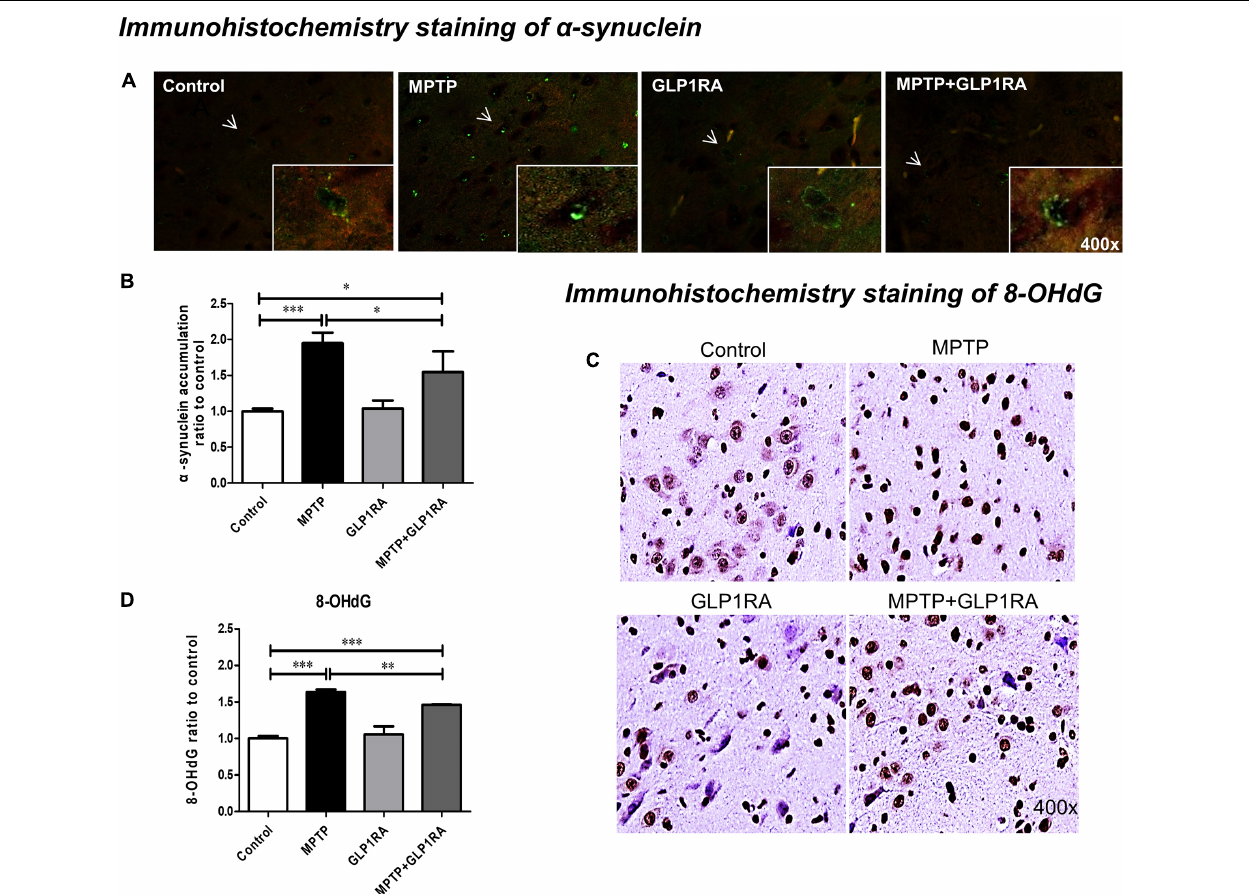
FIGURE 7 | The GLP-1RA (liraglutide) decreases α -synuclein aggregation in substantia nigra and relieves oxidative stress caused by MPTP. IHC staining of α -synuclein ( α -syn), the PD hallmark pathological protein, and 8-hydroxy-2-deoxyguanosine (8-OHDG), an oxidative DNA damage marker, in the substantia nigra were performed for the evaluation of pathological α -syn accumulation and oxidative stress levels. Mice were treated according to the four groups, control/MPTP/GLP-1RA/MPTP + GLP-1RA, and sacrificed on the 3rd day. (A,B) α -syn-IHC stained substantia nigra sections of the four groups (left to right: the control, MPTP, GLP-1RA, and MPTP + GLP-1RA groups) were viewed via 400x fluorescent microscopy (green) and presented as α -syn staining intensity to percentage of the control, quantified using ImageJ software. Note that representative cells with α -syn accumulation are denoted by arrows. n = 3 per group. (C,D) 8-OHdG-IHC-stained substantia nigra sections of the four groups (left to right: the control, MPTP, GLP-1RA, and MPTP + GLP-1RA groups) were viewed via 400x light microscopy and presented as 8-OHdG staining intensity to percentage of the control, quantified using ImageJ software. n = 3 per group. The values represent mean ± SD (one-way ANOVA, * P < 0.05, ** P < 0.01, *** P < 0.001). GLP-1RA, glucagon-like peptide-1 receptor